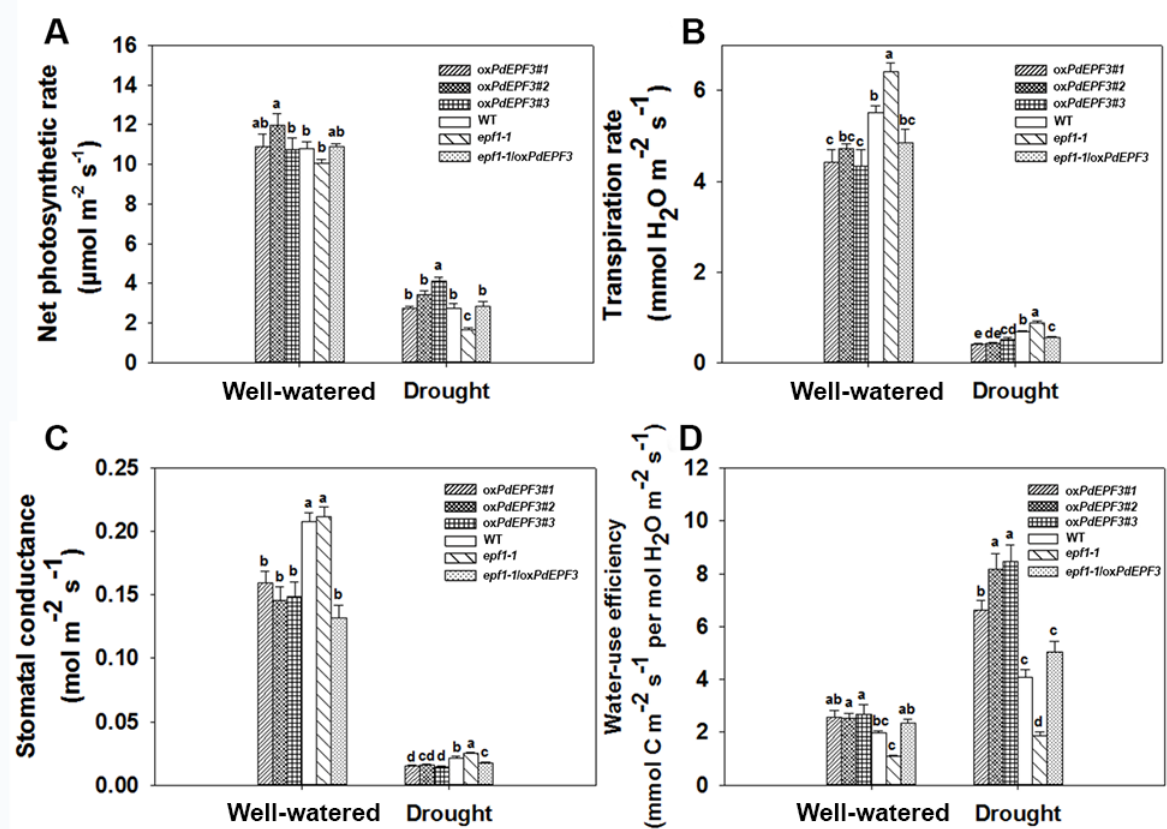
Fig. 7 Physiological analysis of ox PdEPF3 lines under drought stress. Net photosynthetic rate ( A ) transpiration rate ( B ), stomatal conductions ( C ), and instantaneous WUE ( D ) of leaves under well-watered and drought conditions. Data represent means ± SE ( n =